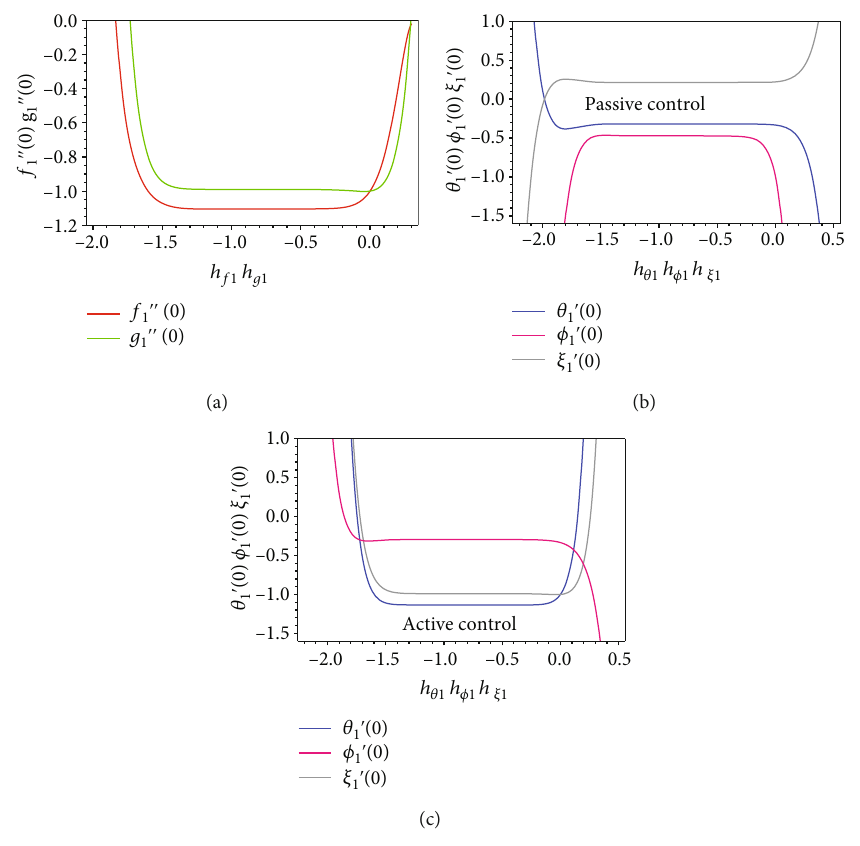
Figure 2: Convergence plots of the HAM solution.